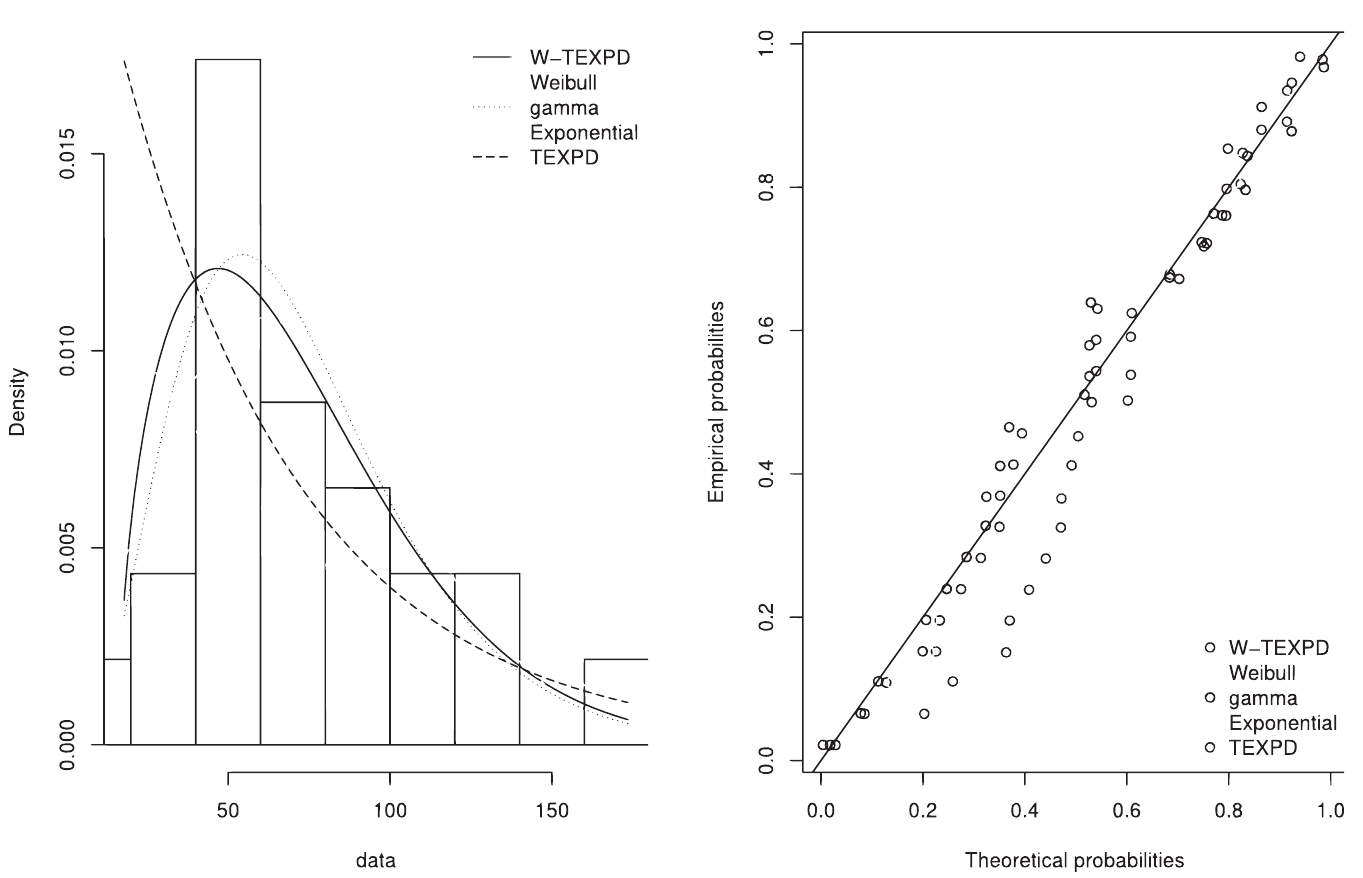
Fig 5. Estimated pdf and P-P plot of W-TEXPD, Weibull, Gamma, Exponential and TEXPD distributions.